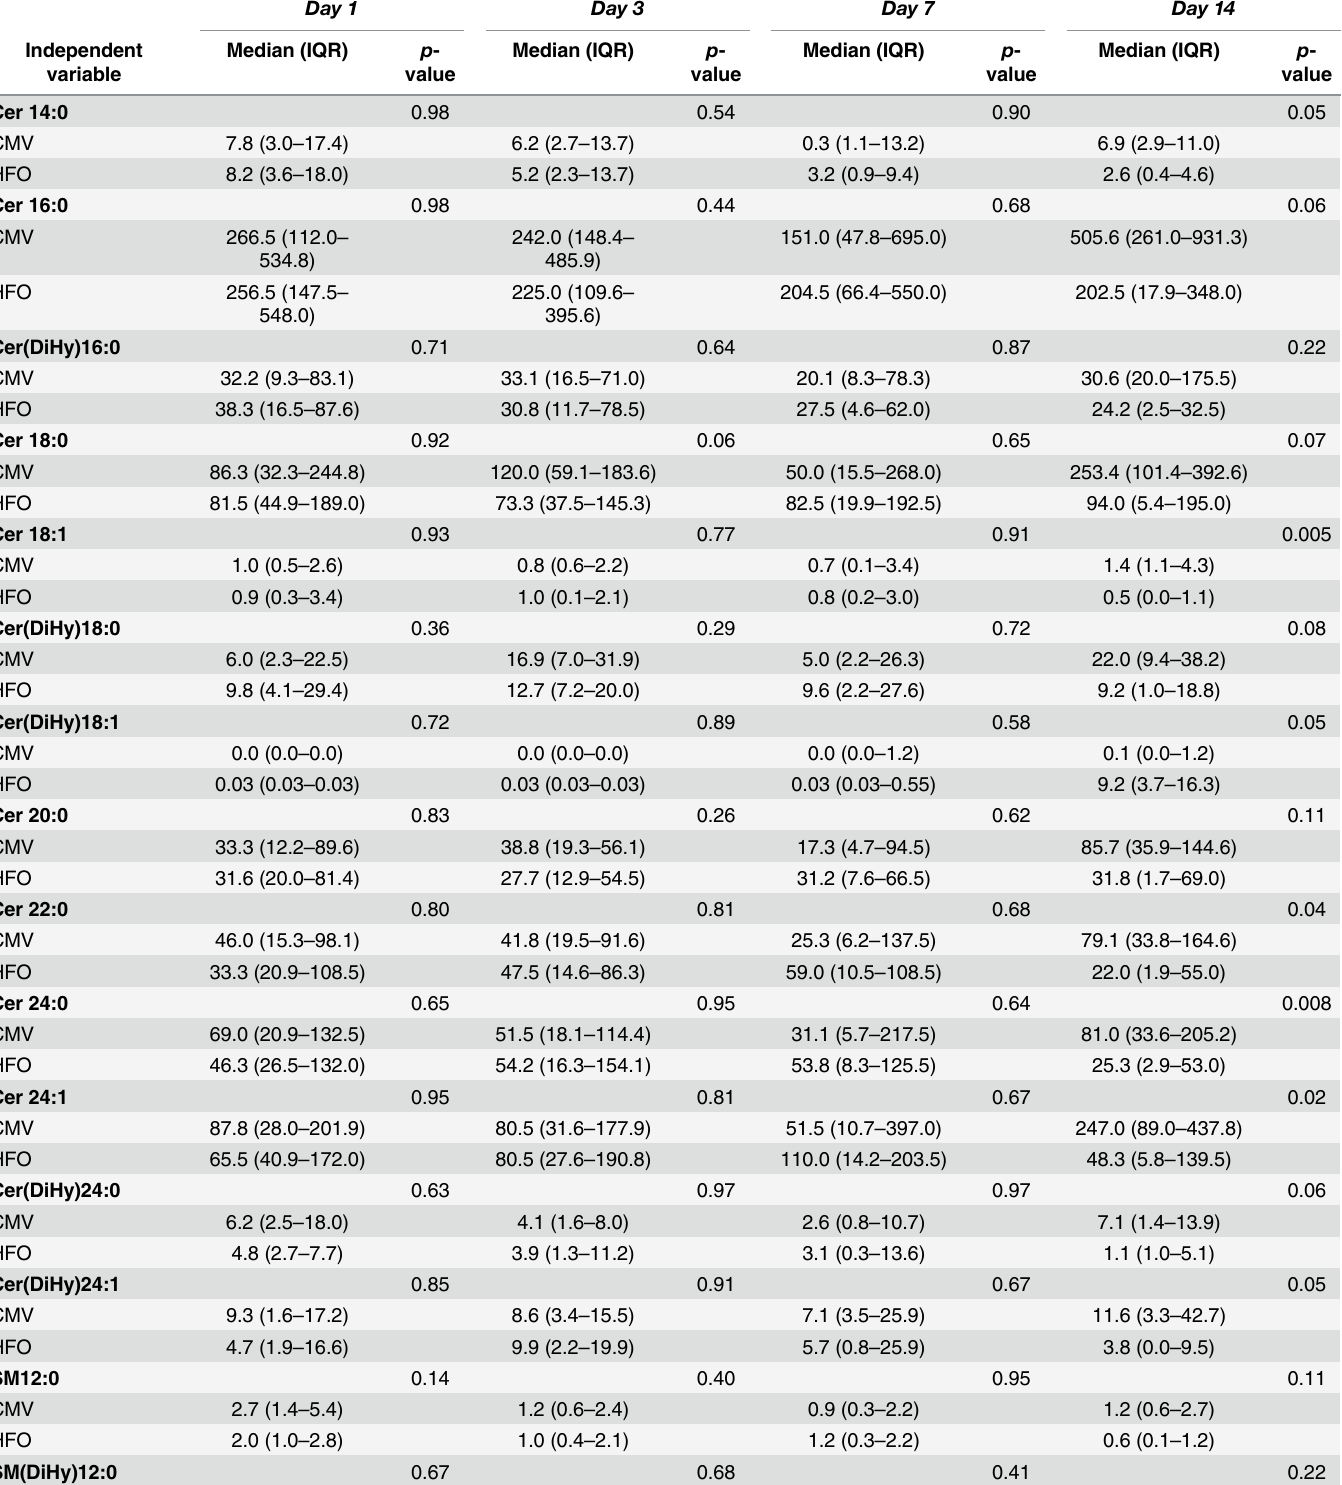
Table 4. Sphingolipid levels for initial ventilation (CMV or HFO). Day 1 Day 3 Day